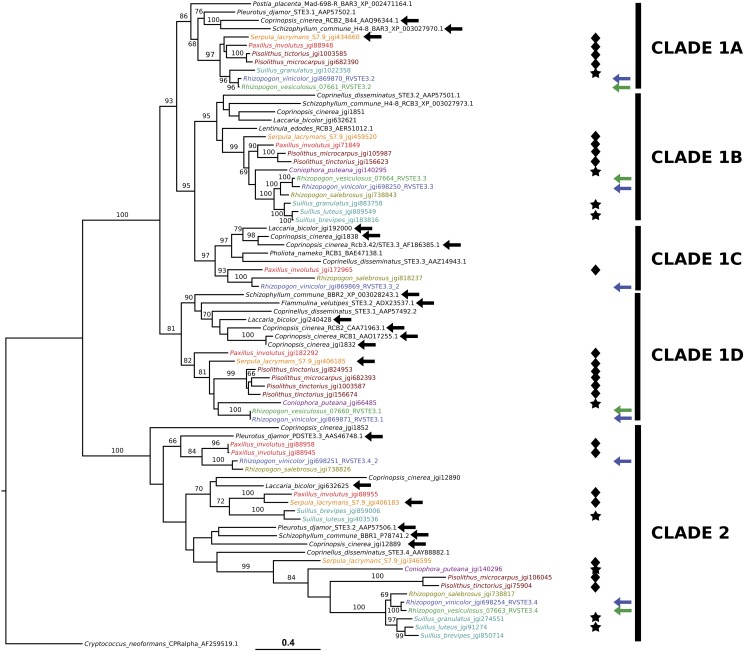
Maximum likelihood phylogram of pheromone receptor genes inferred using RAxML with 1000 bootstrap replicates and the PROTGAMMAGTR model of evolution. Bootstrap support values >60% are shown. Pheromone receptor genes derived from non-Rhizopogon Boletales genomes compared in Figure 4 are color coded by genus. Rhizopogon genes are color coded by species, and R. vinicolor and R. vesiculosus genes are further distinguished by dark blue and green arrows, respectively. Major groups of pheromone receptor genes as identified by James et al. (2004b), Riquelme et al. (2005), and Kües (2015) are here amended, and are denoted at the right margin. Black arrows mark genes of known mating function in F. velutipes (Van Peer et al. 2011), L. bicolor (Niculita-Hirzel et al. 2008), S. lacrymans (Skrede et al. 2013), S. commune (Ohm et al. 2010), and C. cinerea (O’Shea et al. 1998; Halsall et al. 2000; Riquelme et al. 2005; Stajich et al. 2010). Boletales taxa with known bipolar breeding systems are marked with stars, and those with known tetrapolar breeding systems are marked with diamonds.